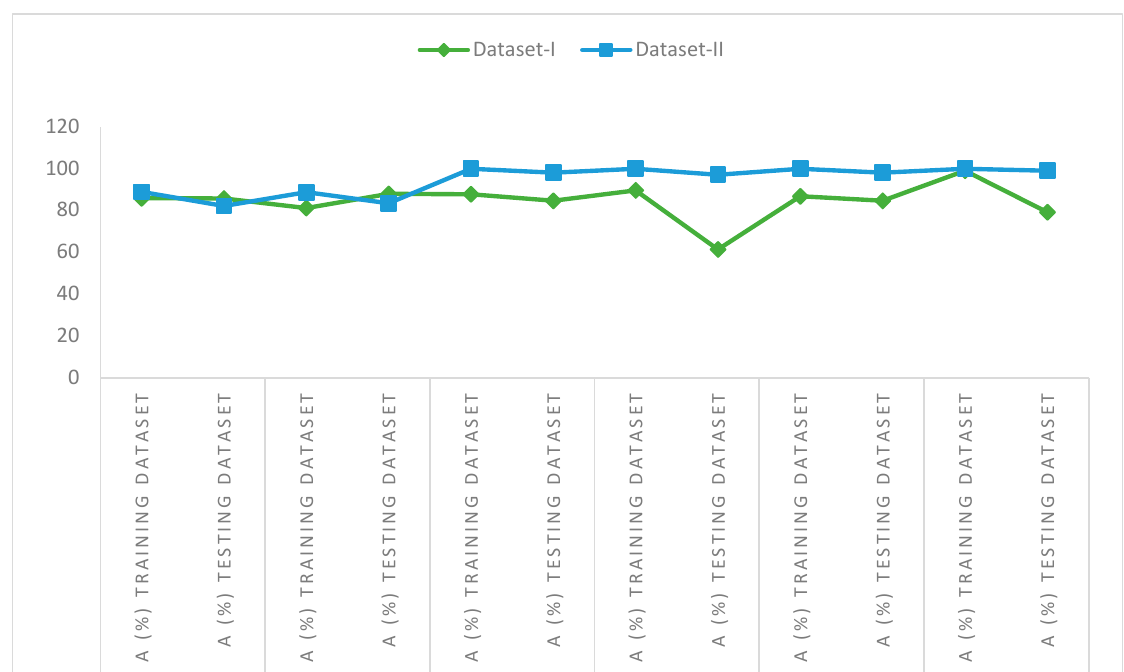
Figure 11. The graphical comparison of the accuracies of training and testing.